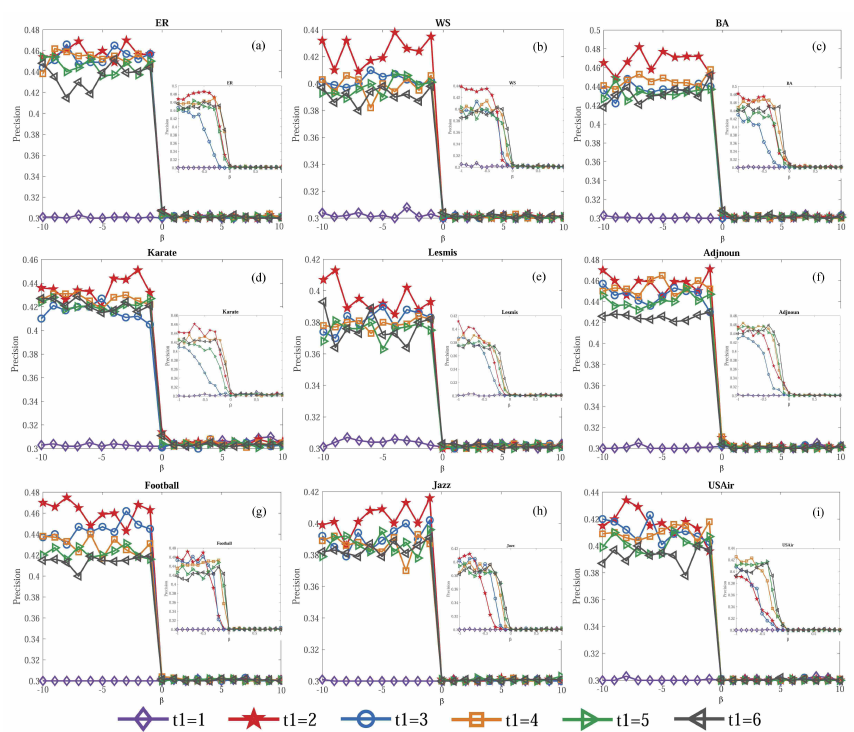
Figure 3. Sources localization accuracy with various frequencies of iteration in nine networks. ( a – i ) The relationship between precision and β in synthetic networks and real networks. Without loss of generality, we suppose α = 1. t 1 denotes the number of